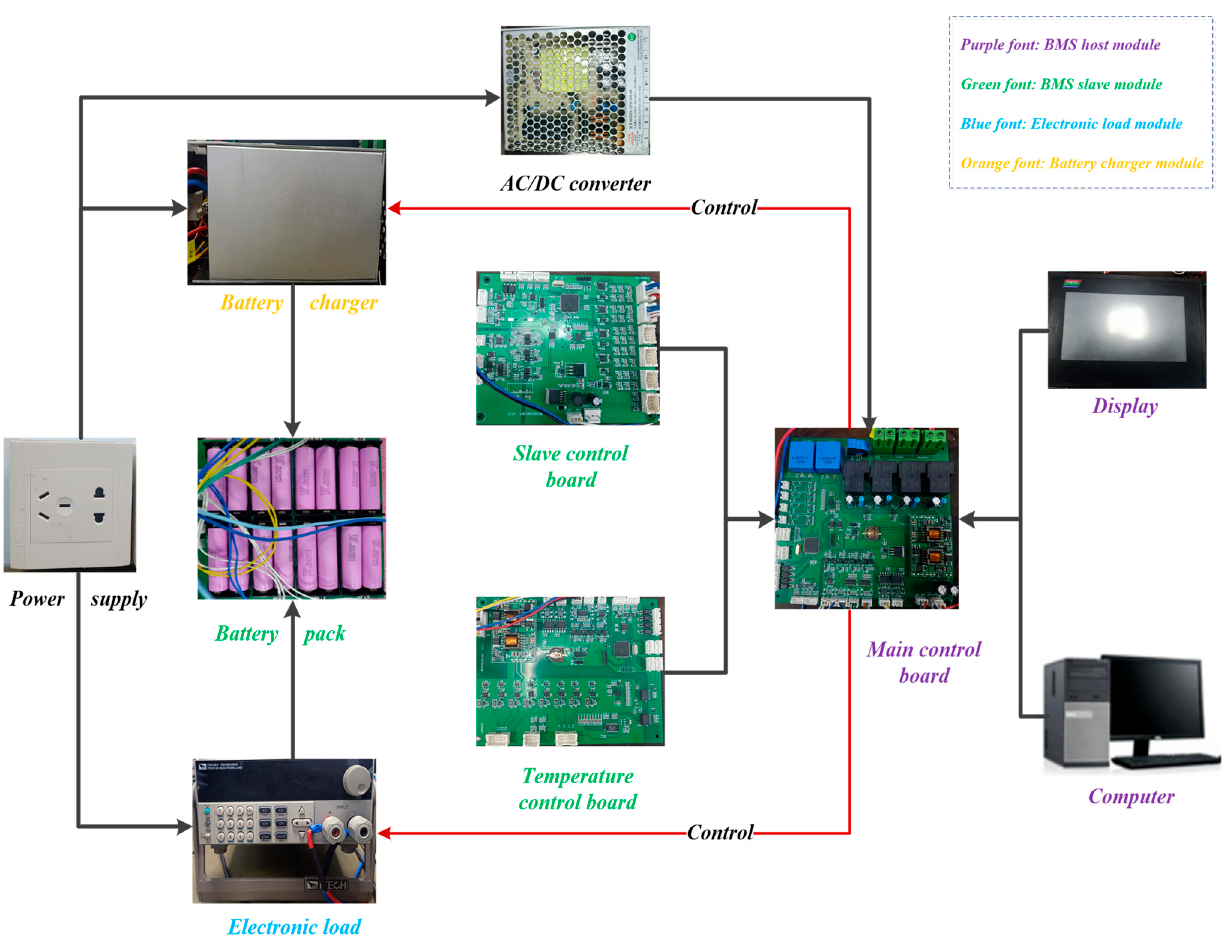
Figure 2. The hardware structure design of the verification platform.